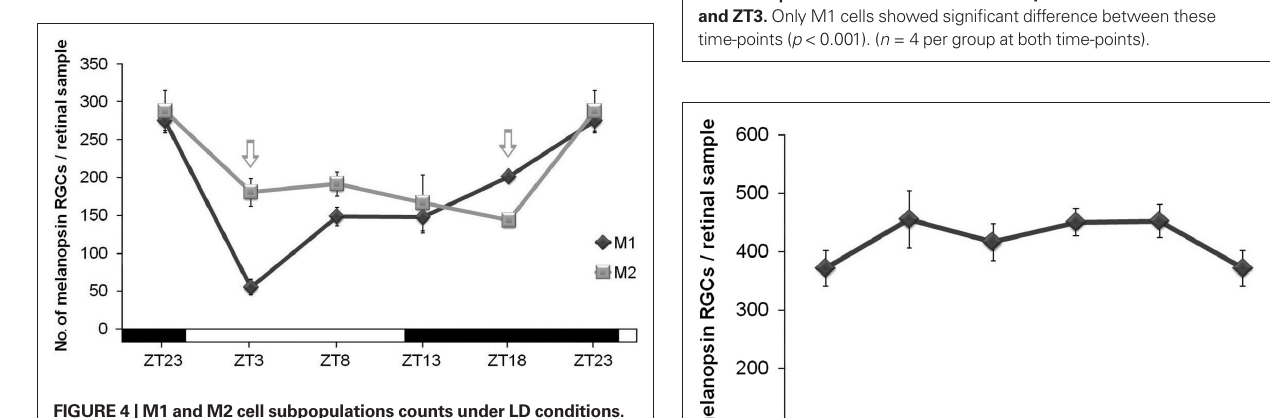
FIGURE 5 | Number of M1 and M2 melanopsin cells of P5 mice at ZT23 and ZT3. Only M1 cells showed signifi cant difference between these